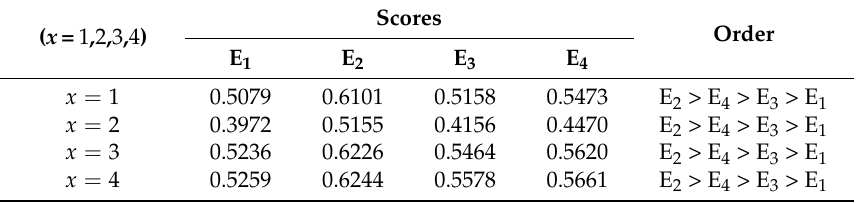
Table 5. Ranking results by utilizing a different parameter vector x in the IVPFWDHM operator.